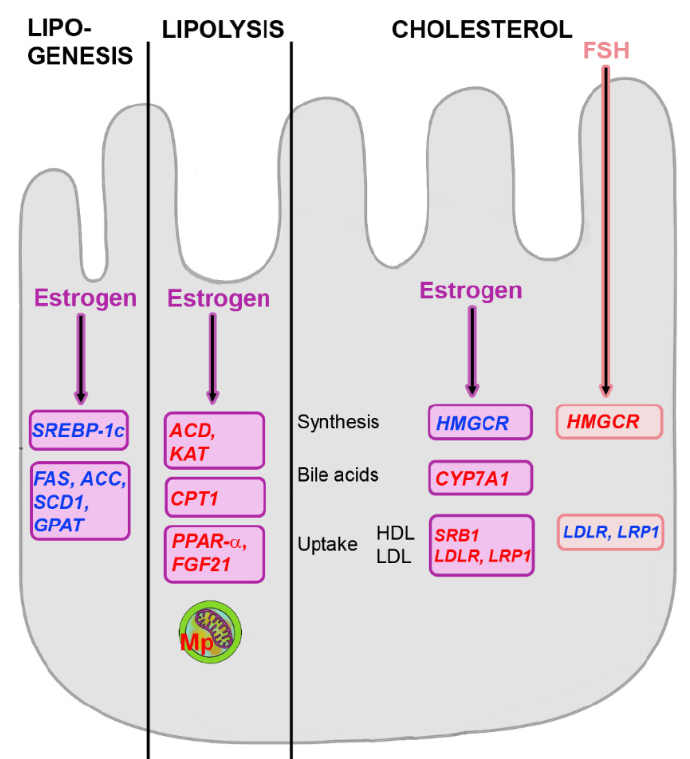
Figure 4. Changes in lipogenesis, lipolysis and cholesterol under the influence of estrogens and fol- licle-stimulating hormone (FSH). Levels of sterol regulatory element-binding protein ( SREBP-1c ) and enzymes of fatty acid (FA) synthesis, fatty acid synthase ( FAS ), acetyl-CoA carboxylase ( ACC ), stearoyl-CoA desaturase ( SCD1 ) and glycerol-3-phosphate acyltransferase ( GPAT ) are decreased. Estrogens increase lipolysis by stimulation of acyl-CoA dehydrogenase ( ACD ), 3-ketoacyl-CoA thi- olase ( KAT ) and carnitine palmitoyl transferase 1 ( CPT1 ). Further, peroxisome proliferator-activated receptor ( PPAR )- α and fibroblast growth factor ( FGF )21 levels and mitophagy (Mp) are increased. Estrogens decrease cholesterol synthesis by downregulation of β -hydroxy- β -methylglutaryl coen- zyme A reductase ( HMGCR ). Upregulation of cholesterol 7a-hydrolase ( CYP7A1) increases trans- formation of cholesterol into bile acids. Uptake of cholesterol is increased by upregulation of scav- enger receptor class B ( SRB1 ) and low-density lipoprotein receptor ( LDLR ) or low-density lipopro- tein receptor-related protein ( LRP1 ). FSH increases cholesterol synthesis by upregulation of HMGCR and decreases uptake by downregulation of LDLR or LRP1 . Increased levels are indicated by red and decreases by blue color. Regulated genes are written in italic.